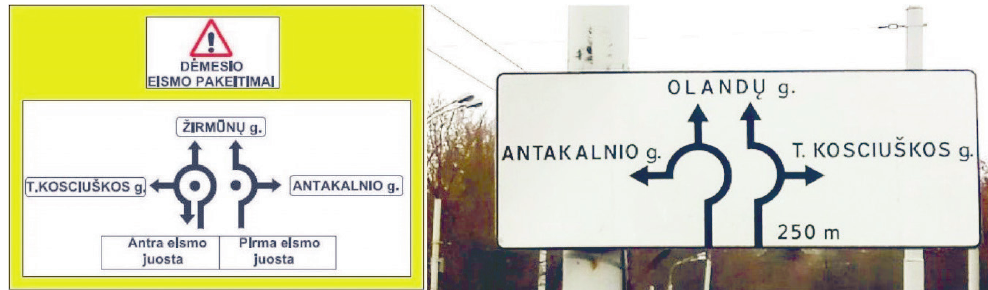
Figure 6. Temporary (on the left) and permanent informative road signs (on the right) informing about traffic organisation